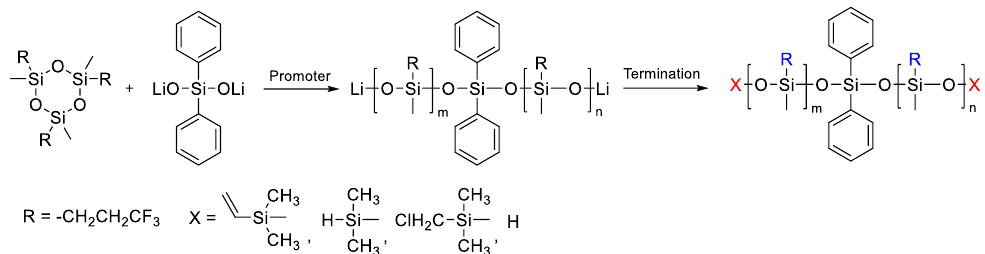
Figure 19. Synthetic routes of PMTFPS with different end groups.